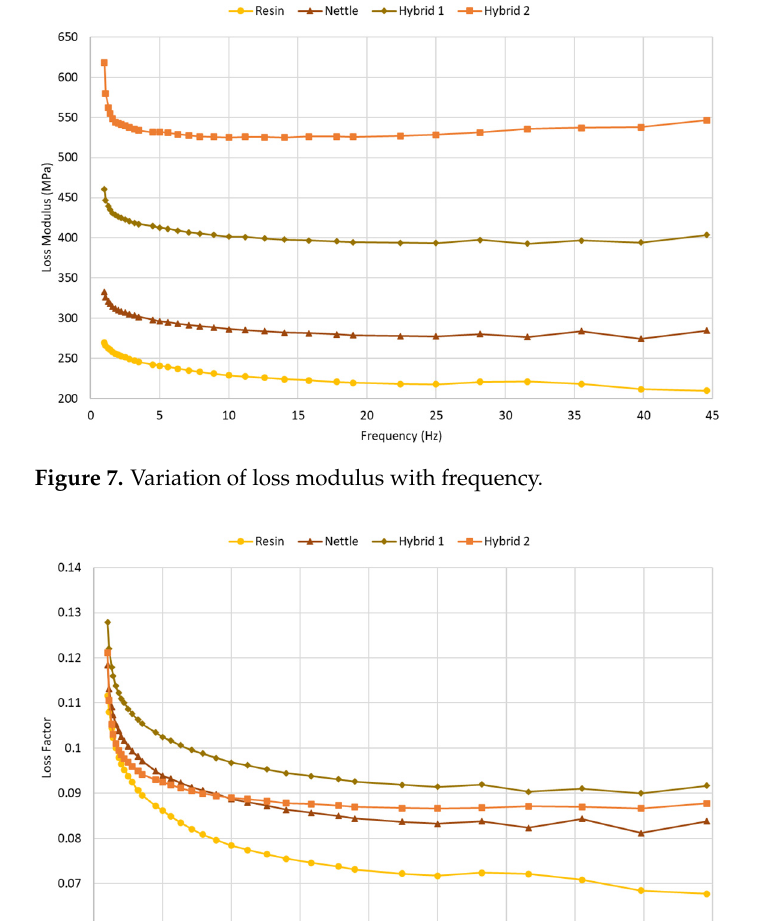
Figure 6. Variation of storage modulus with frequency.